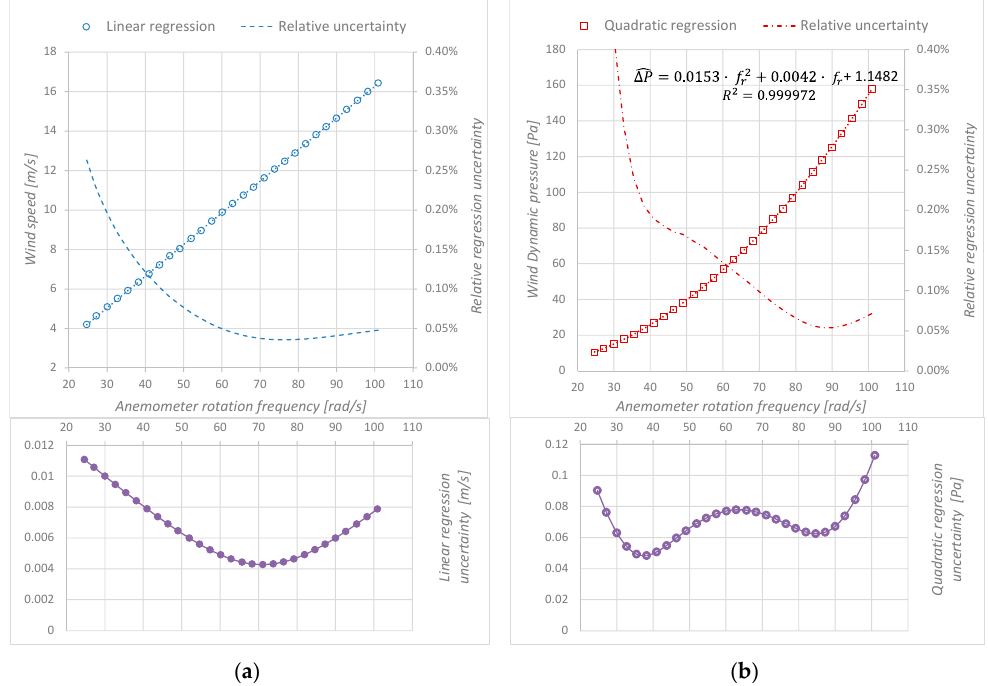
Figure 5. Regression uncertainty: ( a ) Linear regression between “Wind speed” and “Anemometer rotation frequency” (AS-Cup anemometer measurement method), ( b ) Quadratic regression between “Wind dynamic pressure” and “Anemometer rotation frequency” (DYP-Cup anememometer measurement method).